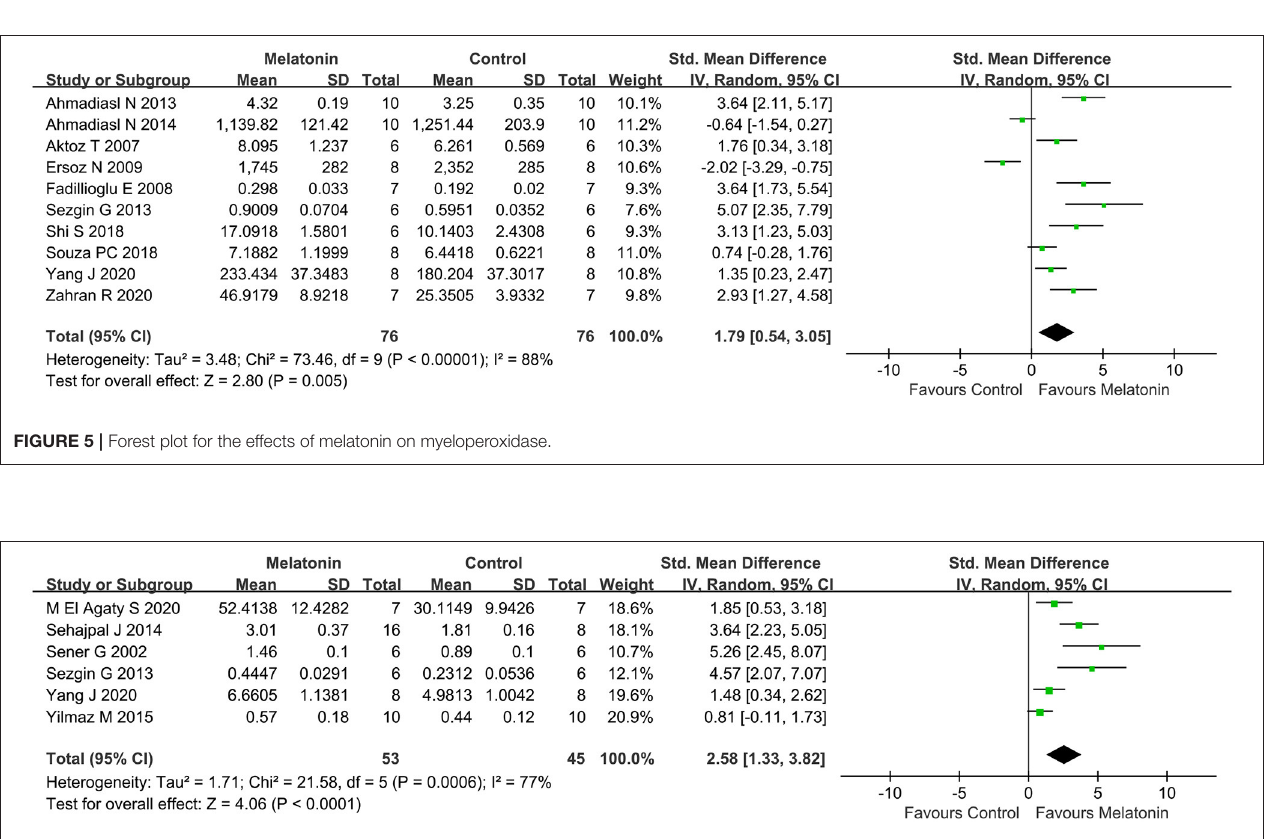
FIGURE 6 | Forest plot for the effects of melatonin on superoxide dismutase.